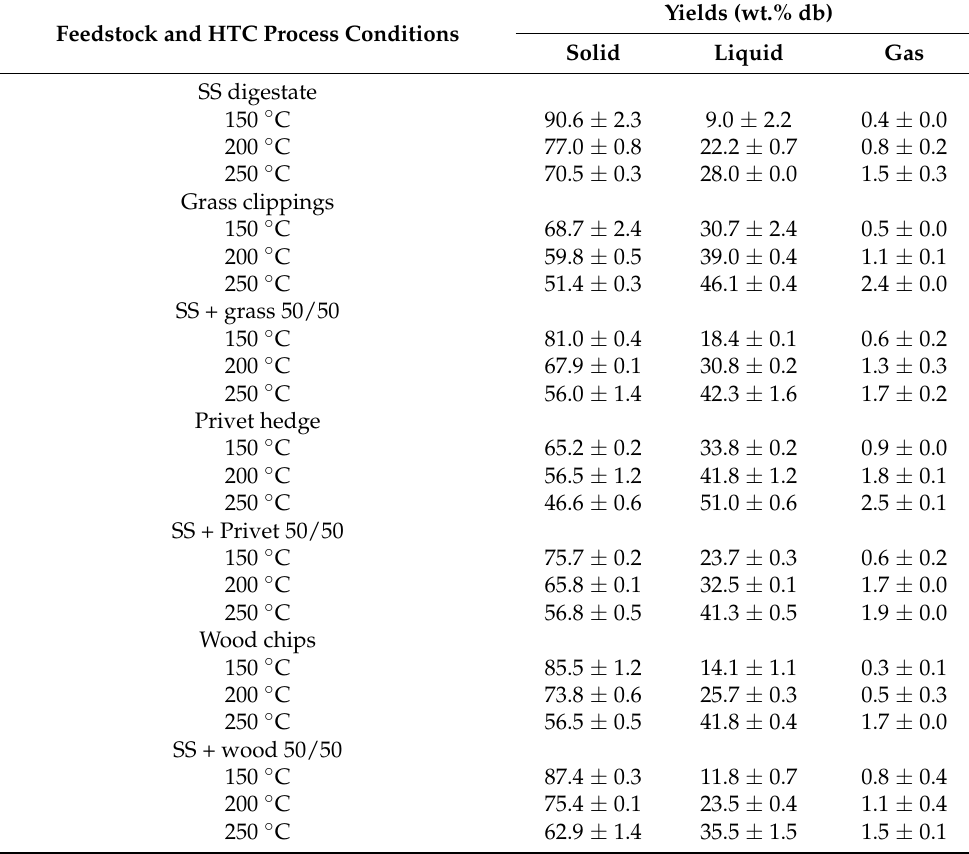
Table 3. Yields of products following hydrothermal carbonisation of SS digestate, lignocellulosic biomass, and 50/50 blends at 20% solid